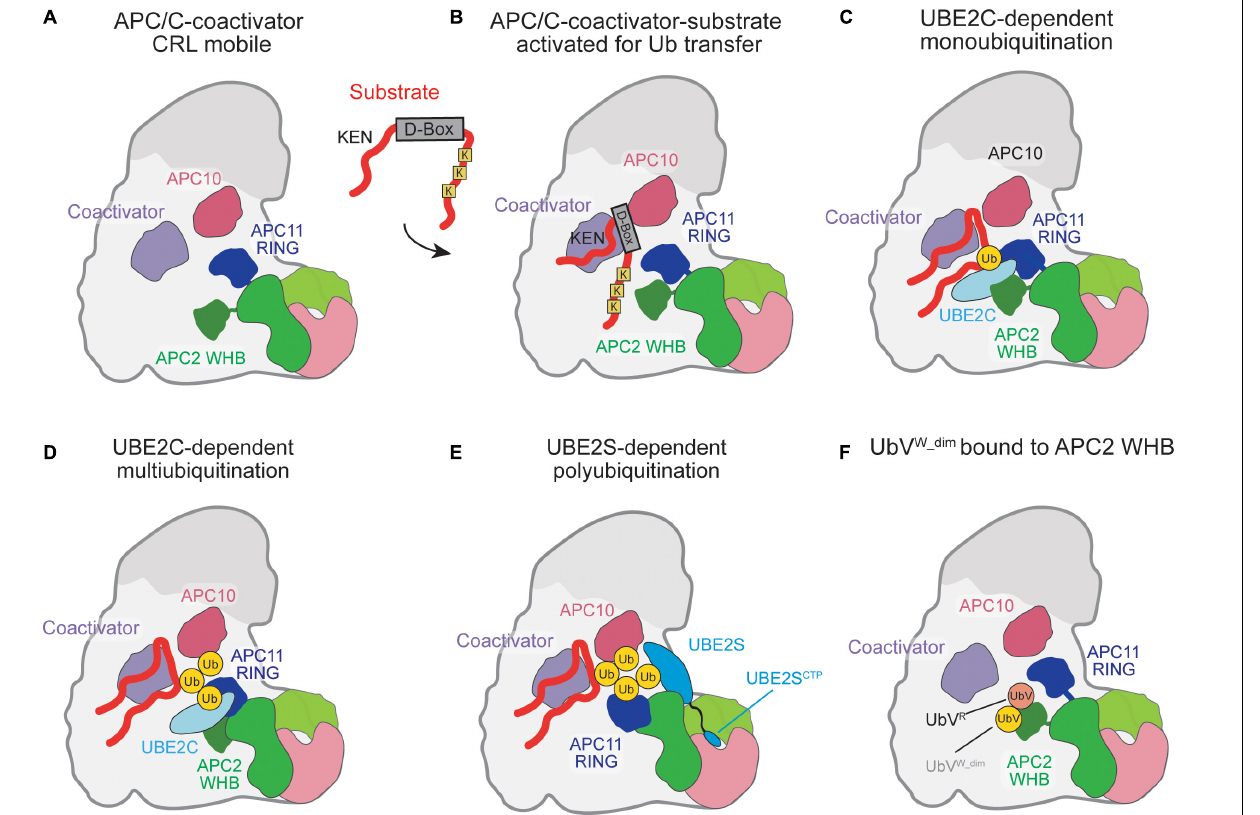
Frontiers in Cell and Developmental Biology |